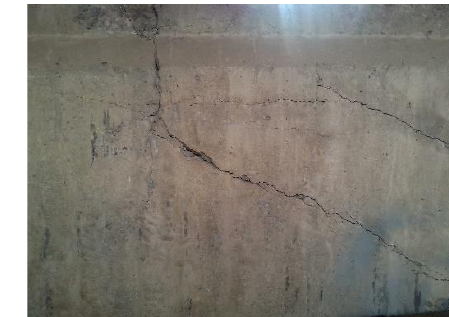
Figure 1. The geometry and size of the hollow-section beam (mm).